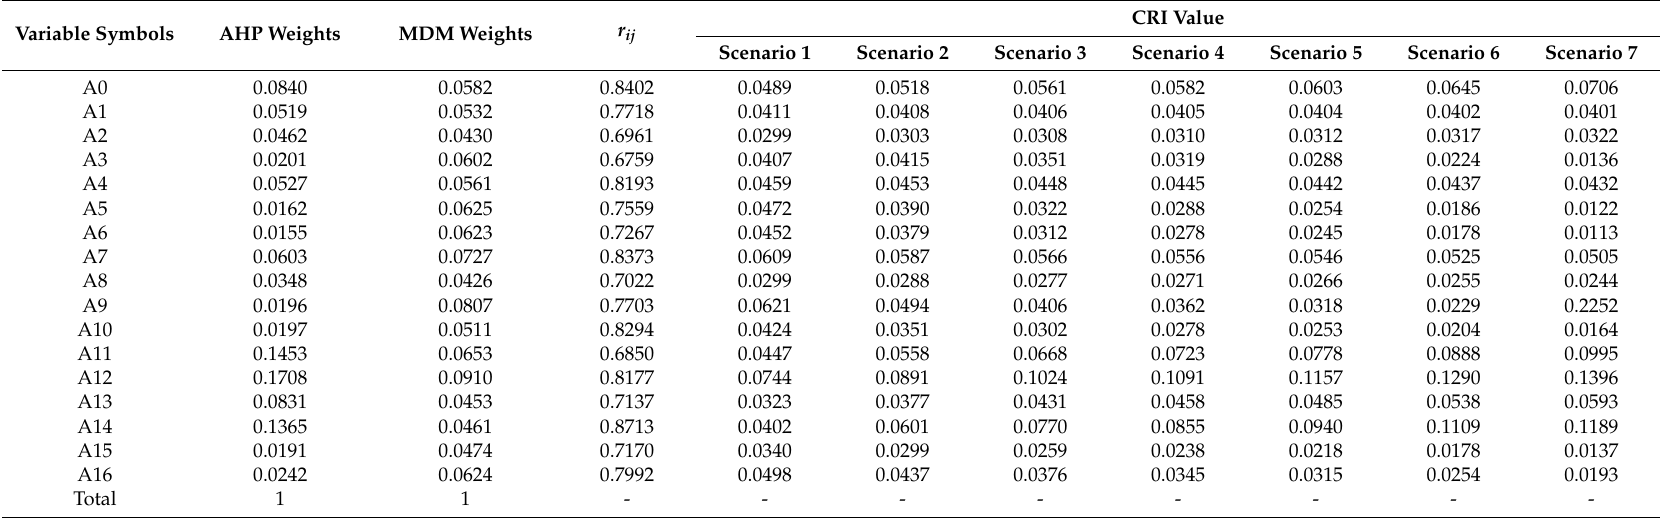
Table 3. Weights of the analytic hierarchy process (AHP) and maximizing deviation method (MDM); values of grey relational coefficients ( r ij ) and the composite risk index (CRI) for secondary salinity risk assessment and mapping in the Keriya